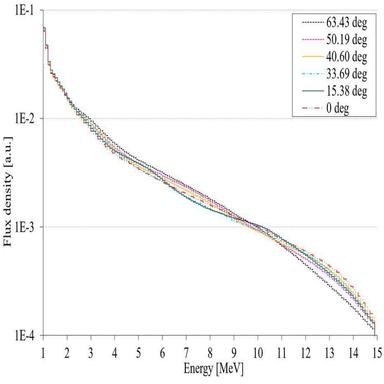
STAYSL adjustment of neutron spectra, visualization of angles is in.